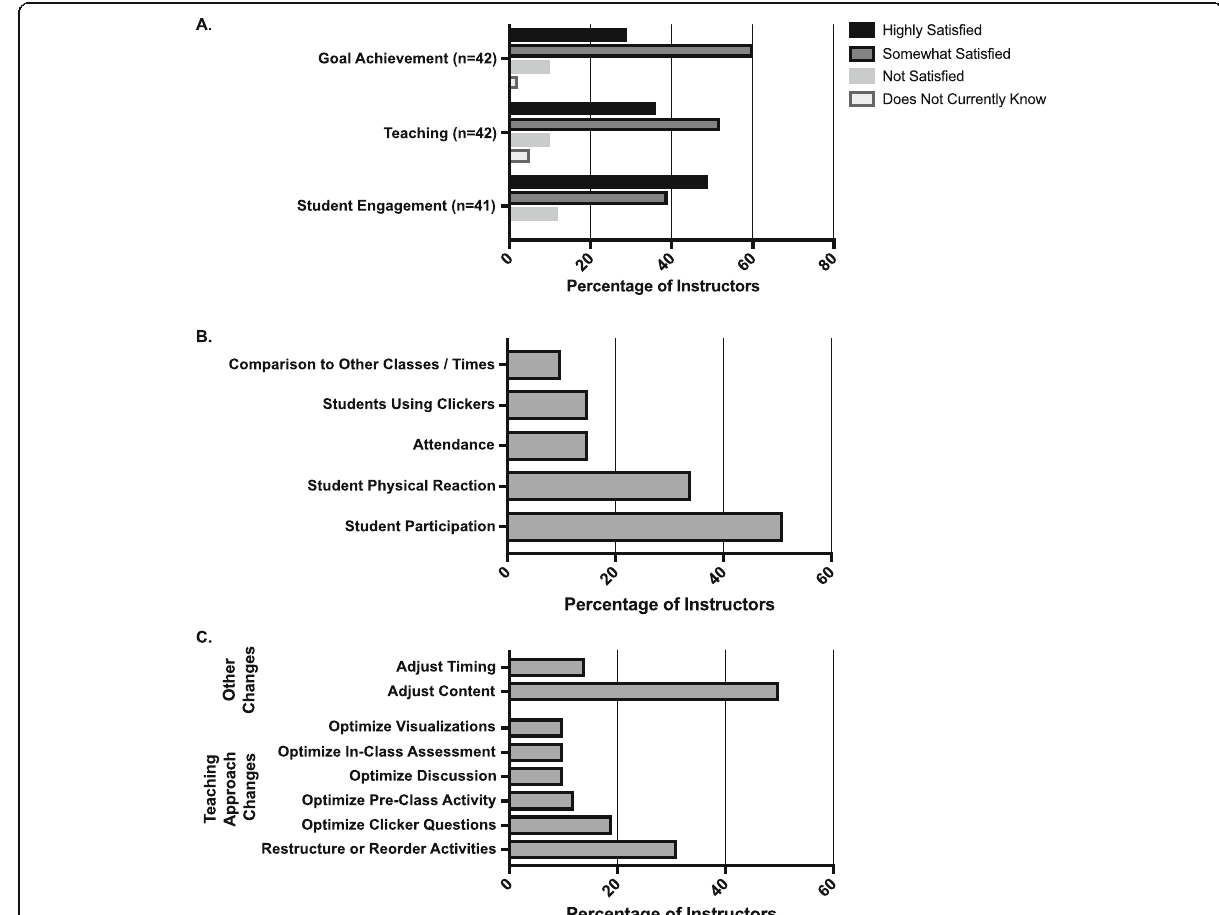
Fig. 2 Instructor reflections. Percentage of instructors reporting in their interview on their a level of satisfaction with teaching, learning goal achievement, and student engagement, b measurement methods that they used to gauge student engagement within their classrooms, and c changes they plan to make when teaching the observed week of classes in the future (only including the instructors that indicated at least one planned change in their